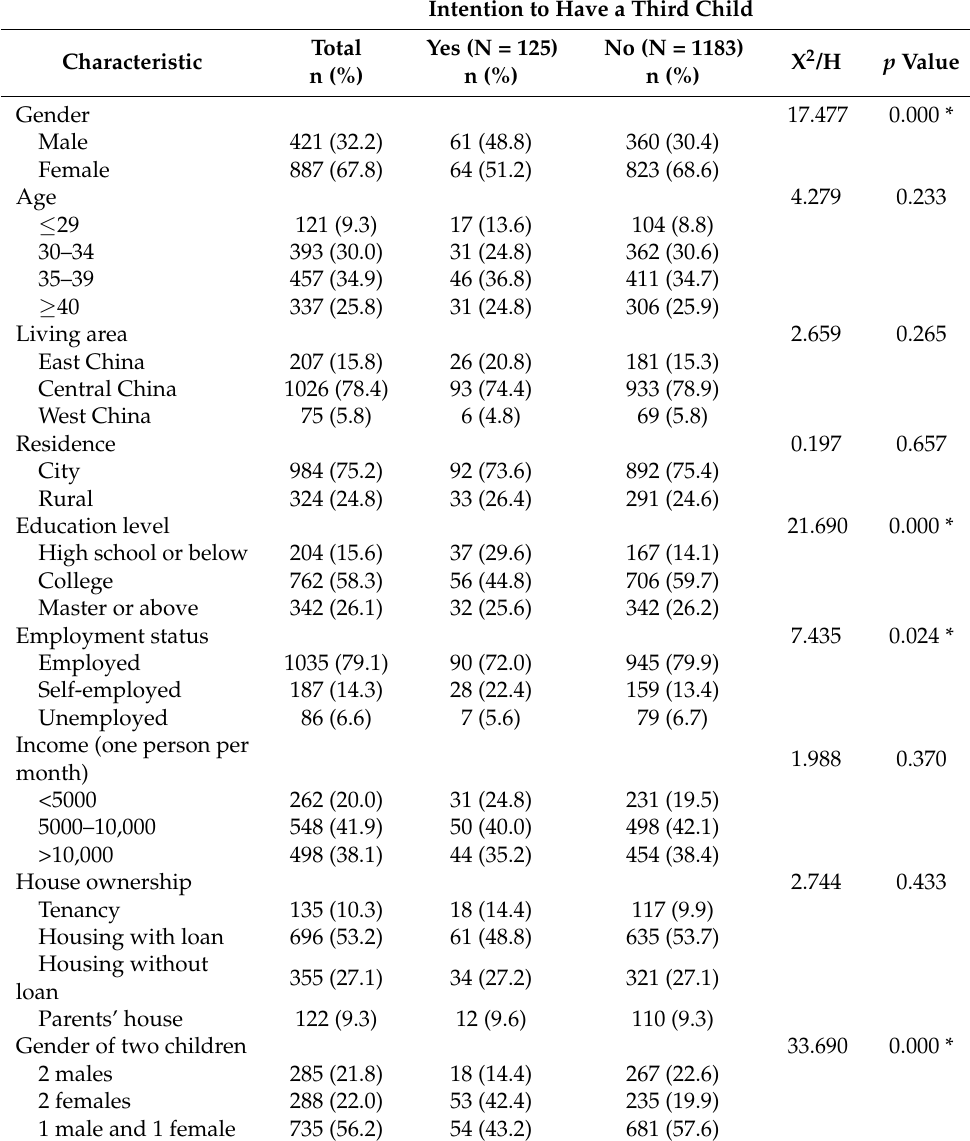
Table 1. Characteristics of all participants (N =